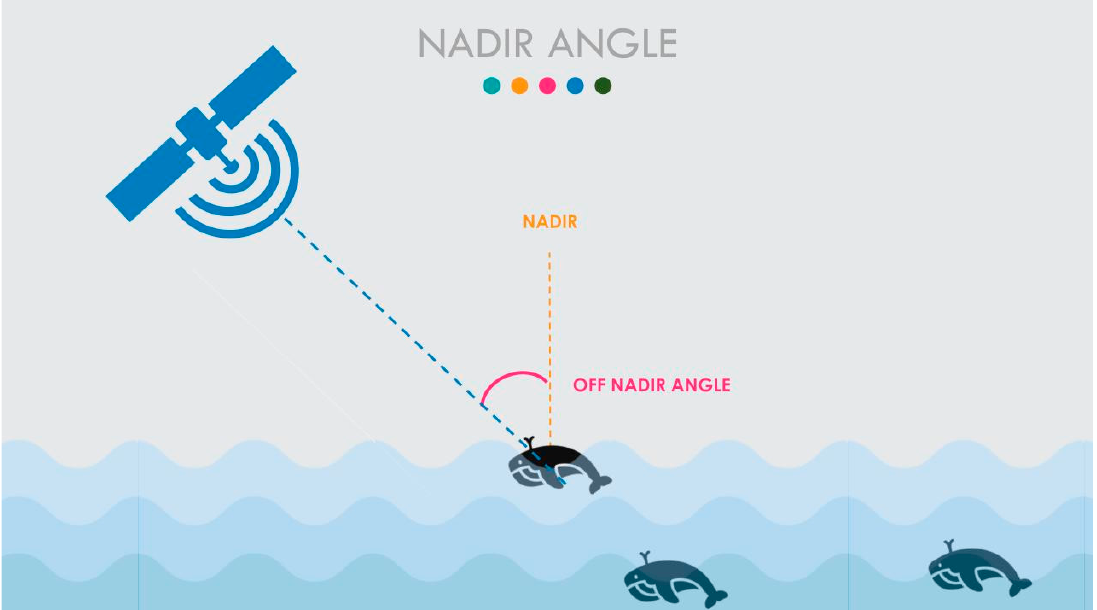
Figure 5. Illustration of nadir and the off-nadir angle when a satellite captures imagery over a whale.